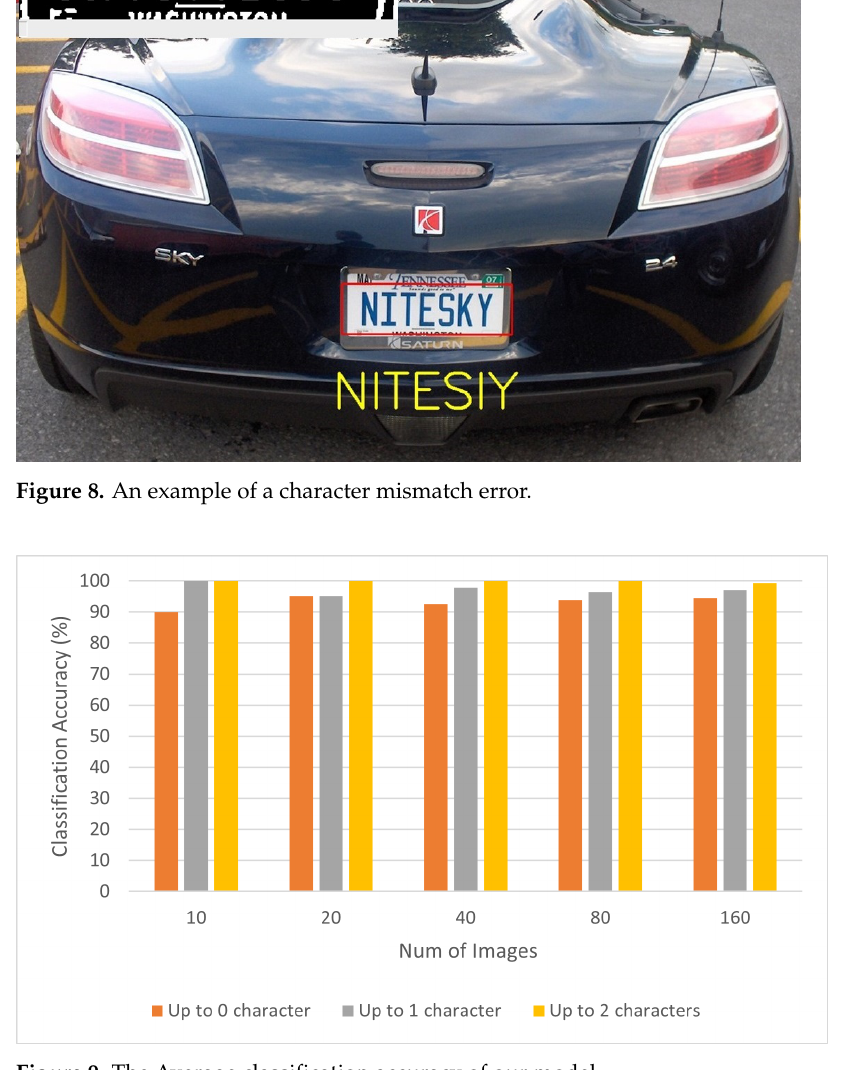
Figure 9. The Average classification accuracy of our